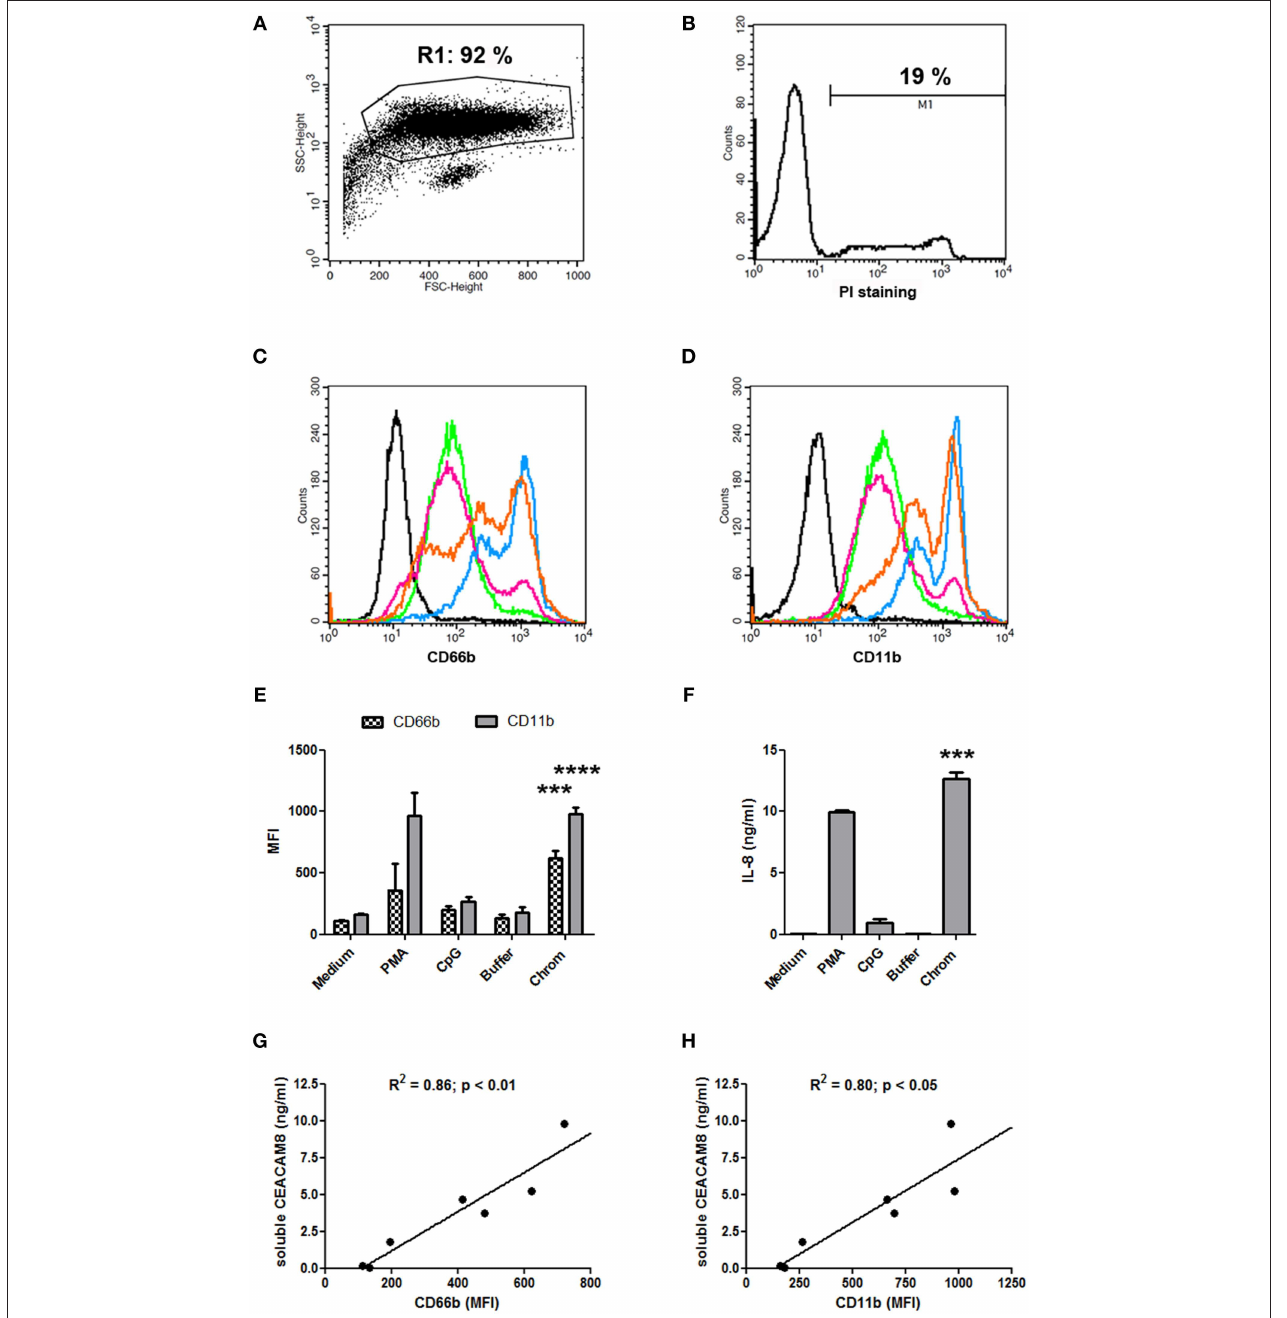
FIGURE 2 | Chromatin-induced soluble CEACAM8 secretion is associated with PMN activation. (A,B) Classical PMN shape (A) after 14h of cell culture in medium only (non-activated PMN) and percentage of dead cells (B) . PMN were analyzed by flow cytometry after staining with propidium iodide (PI). Size (FSC) and granularity (SSC) are depicted. Numbers represent percentages of gated cells and dead (PI-positive) PMN. (C–F) After 14h, cell activation was estimated by flow cytometry (C–E) or ELISA (F) with PMN from Figure 1C . (C,D) Representative plasma membrane CD66b (CEACAM8) (C) and plasma membrane CD11b (D) expressions after chromatin activation are represented. Black histogram, PMN in medium stained with isotype control. All other histograms represent PMN stained with CD66b- or CD11b-specific mAb; green, PMN in medium; pink, PMN with chromatin purification buffer; orange, PMN with 1 µ g/ml chromatin; blue, PMN with 4 µ g/ml chromatin. (E) CD66b (CEACAM8) and CD11b expression levels for all stimuli are summarized (chromatin, 4 µ g/ml). MFI, mean fluorescence intensity. (F) IL-8 secretion was quantified (chromatin, 4 µ g/ml). (G,H) Correlations between concentrations of secreted soluble CEACAM8 and levels of plasma membrane CD66b (CEACAM8) (G) and CD11b (H) expression by activated PMN were determined using two-tailed Spearman tests. Shown is one representative experiment of seven independent experiments using different donors and different chromatin preparations. Mean and SD of triplicates are shown. *** p < 0.001; **** p < 0.0001 for PMN cultured with chromatin vs. the purification